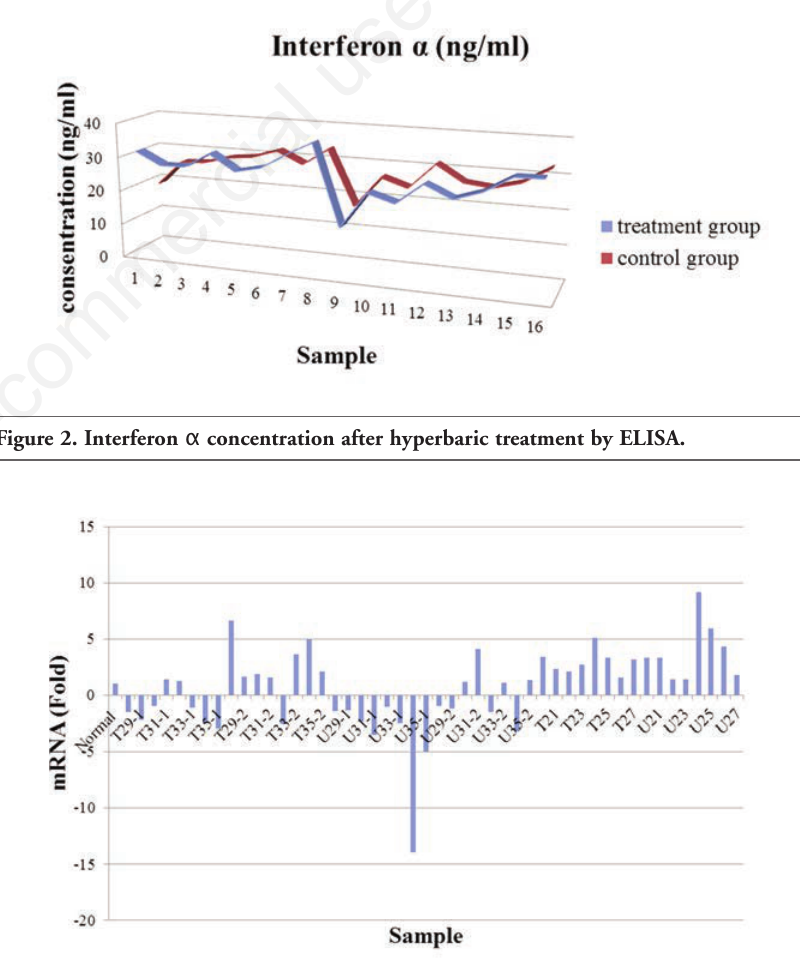
2 after hyperbaric treatment (U= untreatment, α